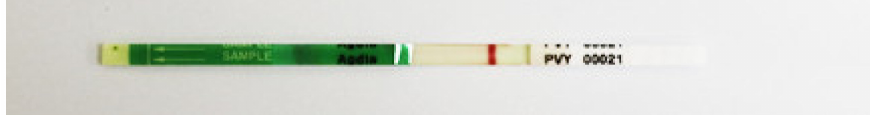
Figure 1. Potato virus Y (PVY) testing of the seedlings. Table 1. Light spectrum ratios for potato production in the aeroponic system. Spectrum Combinations Ratio (%)